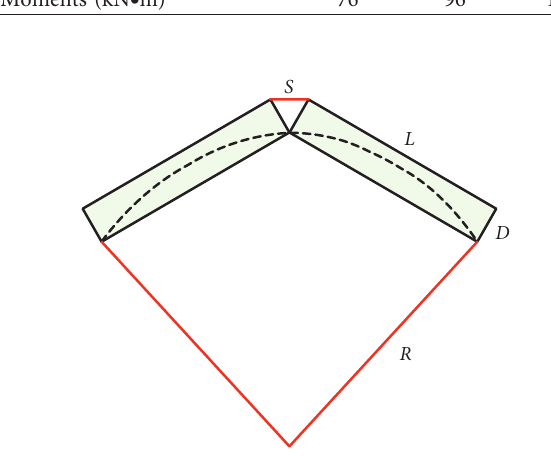
Figure 23: Calculation diagram. Table 5: Relationships among the curvature radius, joint opening, bolt stress, and joint